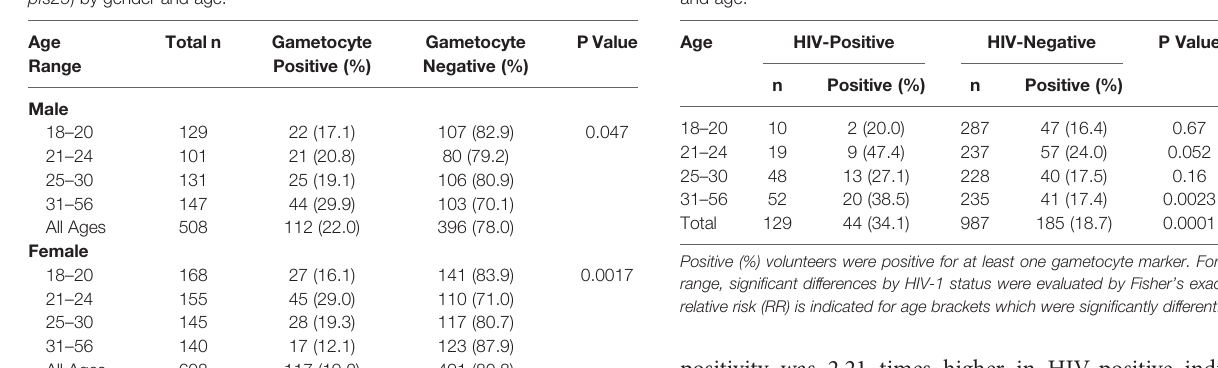
TABLE 3 | Comparison of gametocyte-positive samples (n) by HIV-1 status and age.